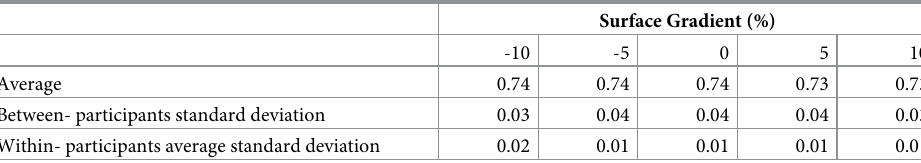
Table 5. Running (2.25 m/s) cycle time (s) over a range of surface